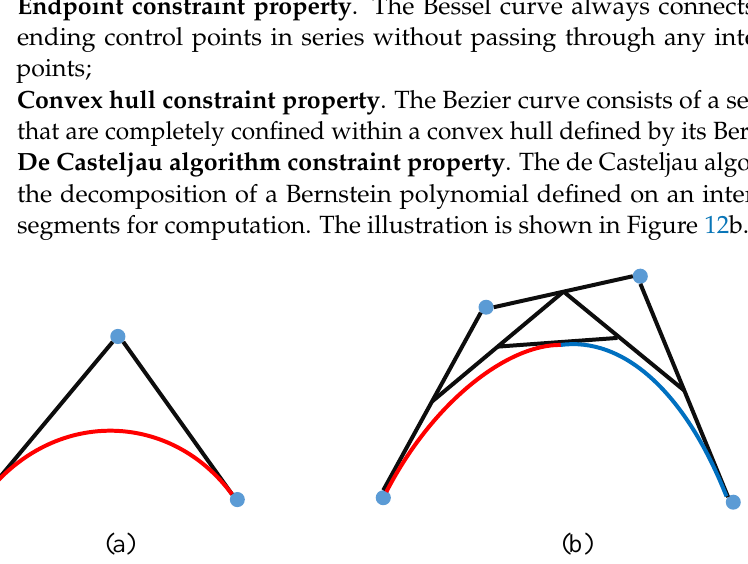
Figure 12. ( a , b ) are schematic diagrams of Bessel curves of second order and third order, respectively. ( b ) shows a geometric example of de Casteljau’s algorithm to split Bernstein polynomials. The Bessel curve on the left is shown in red, and the curve on the right is shown in blue. The schematic diagram of the proposed global segmented smooth trajectory generation is shown in Figure 13.